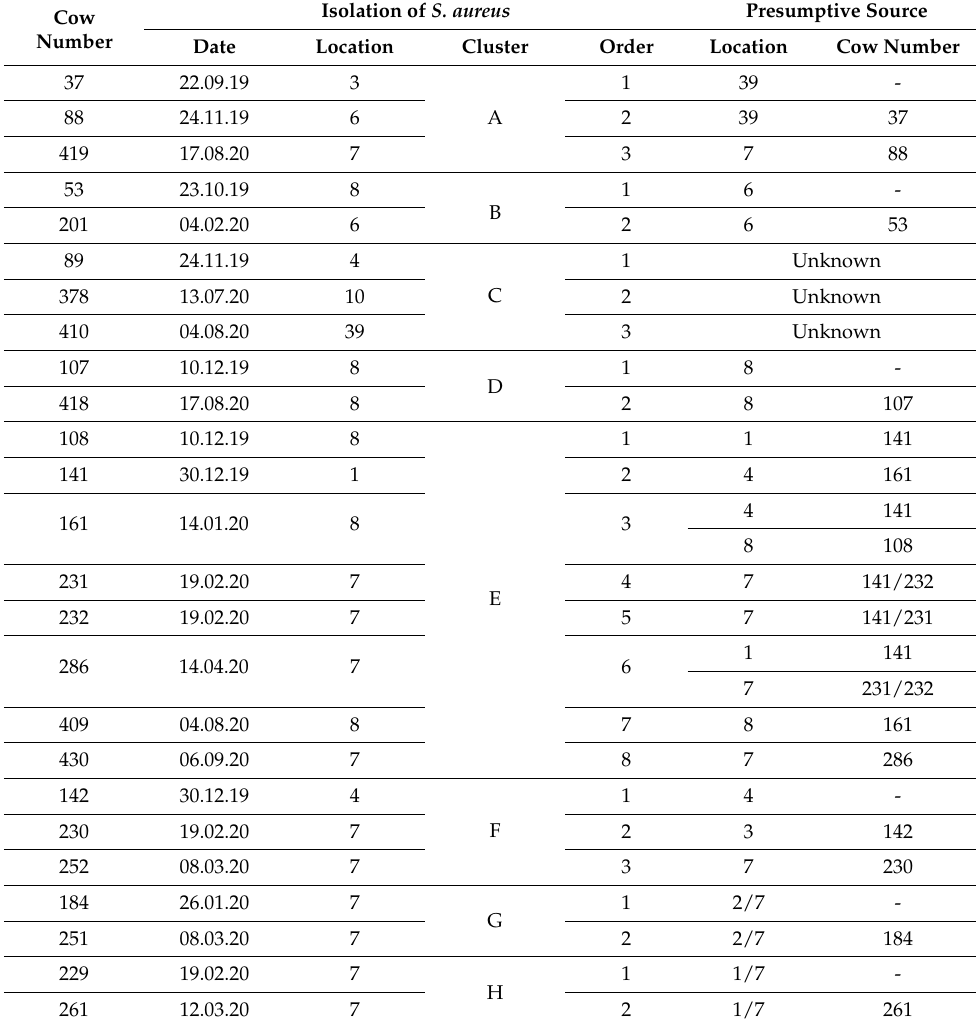
Table 2. Individual acquisition analysis of the t2873 strain within farm ‘A’. For each infected cow, the date, location (milking group) and molecular cluster are presented as well as the order of isolation within each cluster. The presumptive source was analyzed based on shared molecular cluster, time and place, except for the first cow within each